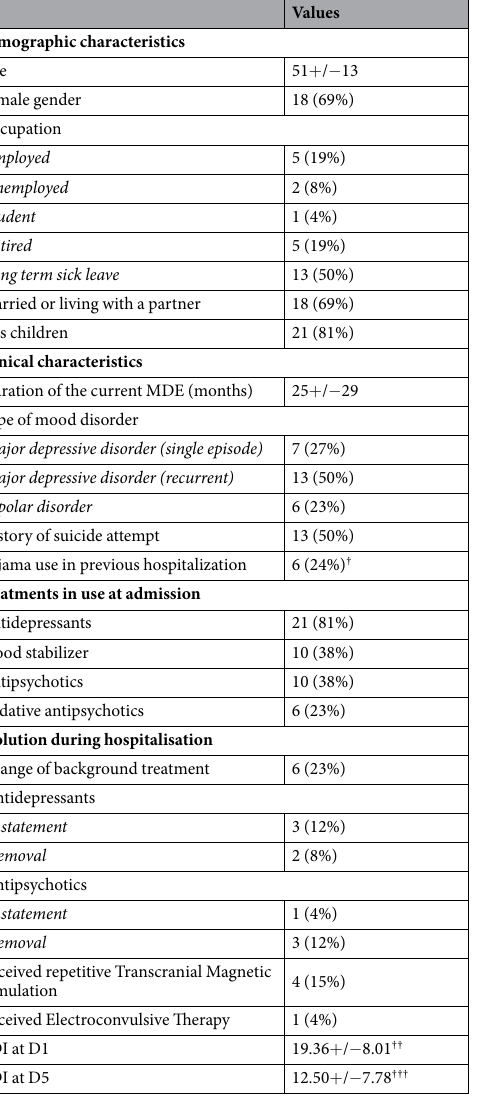
Table 1. Demographic and Clinical Characteristics of the 26 Patients with Major Depressive Episode (MDE). For all results, data are summarized numerically, with mean ( + / − Standard Deviation) for quantitative outcomes and numbers (percentage) for categorical outcomes. D1: Day 1. D5: Day 5. BDI: Beck Depression Inventory. † 1 missing data. †† For one patient, 3 items in the BDI were missing and replaced by the mean score on the scale. ††† For two patients, 3 items in the BDI were missing and replaced by the mean score on the